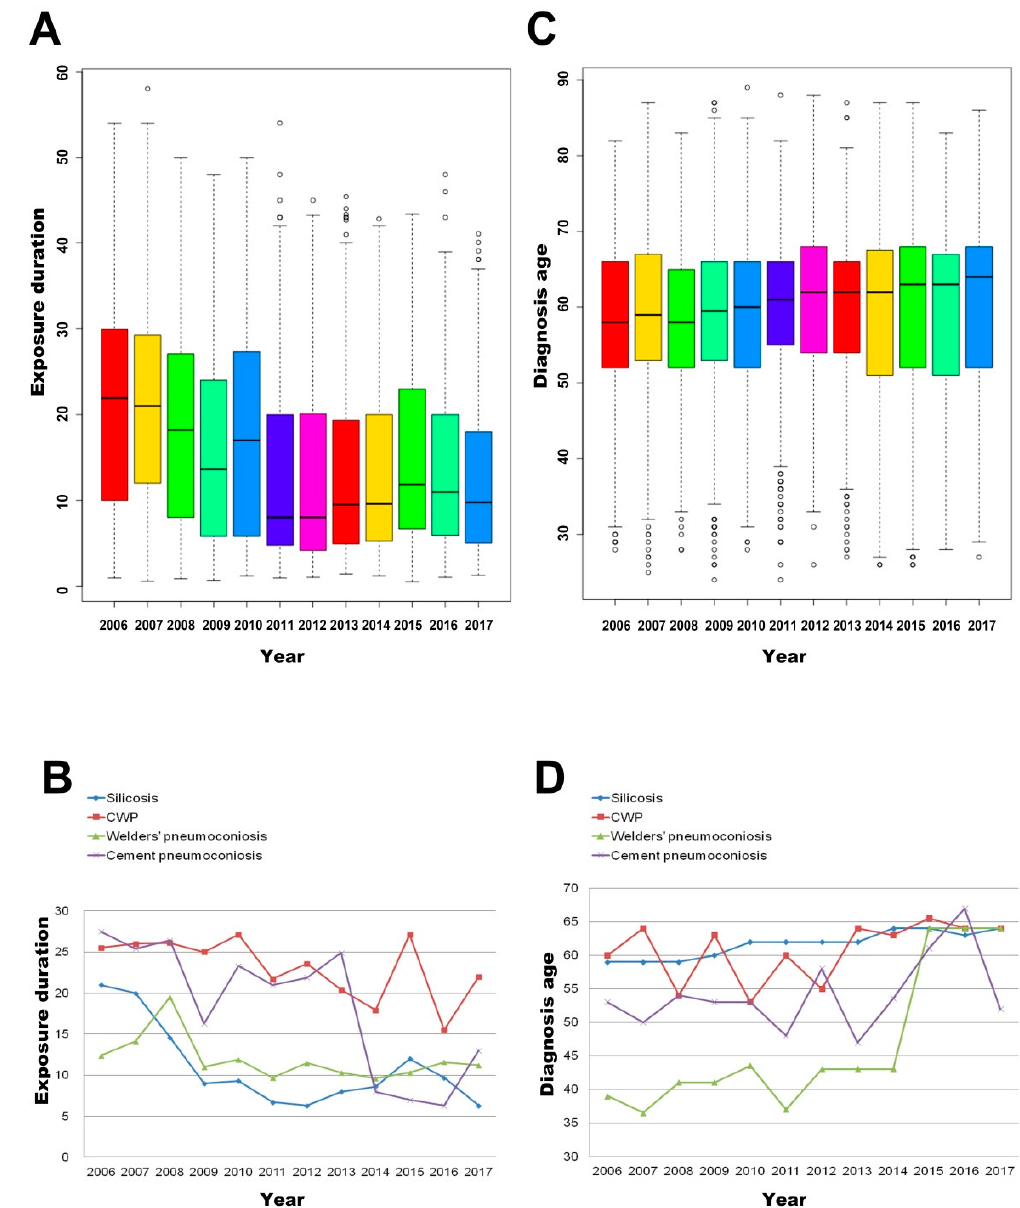
Figure 5. The overall annual trend of the average exposure duration and diagnosis age of pneumoconiosis cases from 2006 to 2017. ( A ) The overall annual trend of the average exposure duration of pneumoconiosis cases. ( B ) Changes in average exposure duration of different types of pneumoconiosis cases. ( C ) The overall annual trend of the average diagnosis age of pneumoconiosis cases. ( D ) Changes in the average diagnosis age of different types of pneumoconiosis cases.